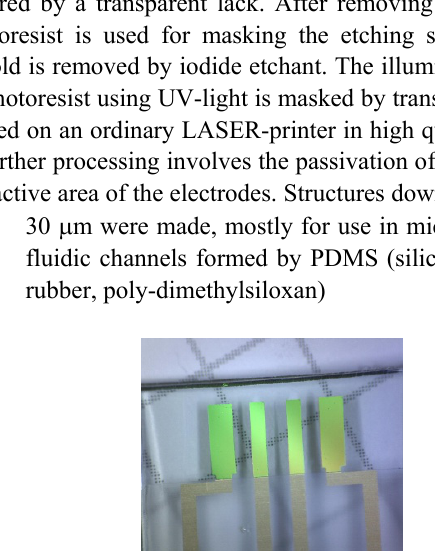
Fig.5: Schematic of a stray field sensor with electric modeling. These sensors with interdigitated metallic electrodes with distances between 1 (cid:80) m and 150 (cid:80) m are built on a silicon wafer with silicon nitride as passivation layer. Sensors like these are useful as galvanically decoupled impedance sensors. (CiS Forschungs-institut für Mikroelektronik und Photovoltaik GmbH, Erfurt, Germany).